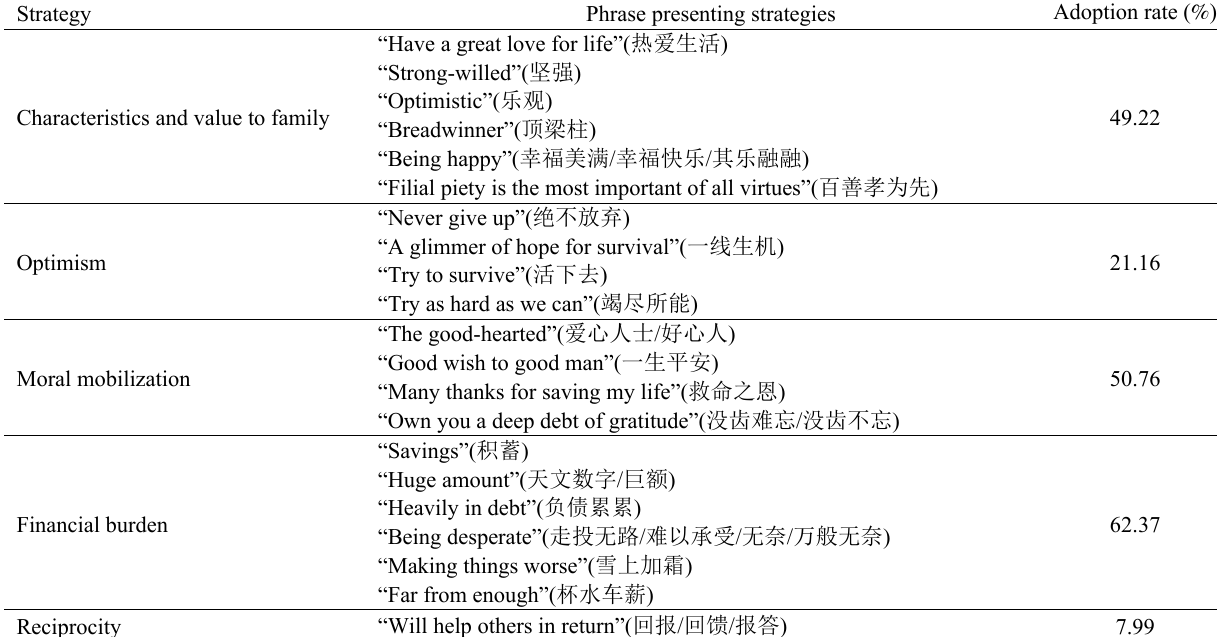
Table 2 Narrative strategies and sample wordings (N=49